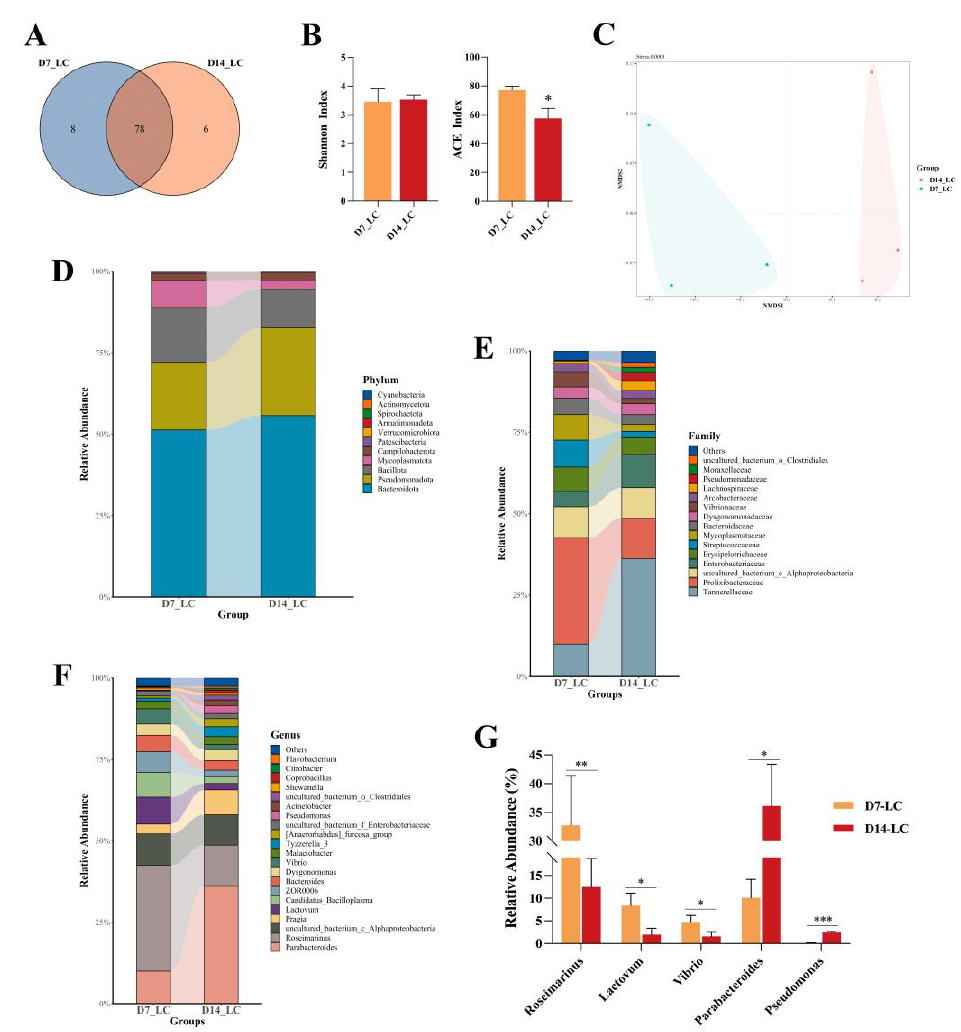
Figure 6. Low concentration of FF-exposure altered the diversity of the intestinal microbial community in crabs between day 7 and day 14. ( A ) The Venn diagram analysis of OTUs. ( B ) Alpha diversity: Shannon index and ACE index. ( C ) NMDS based on Bray – Curtis distance. ( D – F ) Relative abundance of gut bacterial composition at phylum, family and genus level. ( G ) Metastats analysis of different phyla in intestinal microbiota at the genus level. The asterisks “*” indicate statistical significance compared to the control group (* p < 0.05, ** p < 0.01 and *** p < 0.001). Bars represent the mean ± SEM (n =